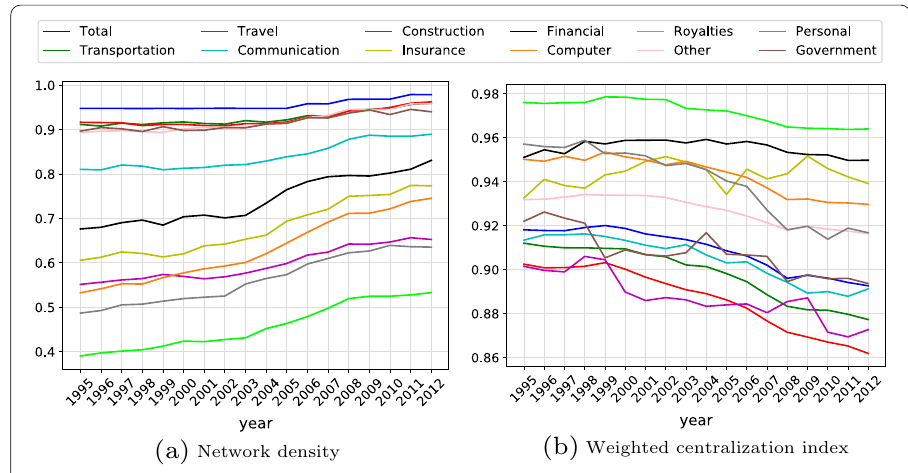
Fig. 2 Network density and weighted centralization index per service